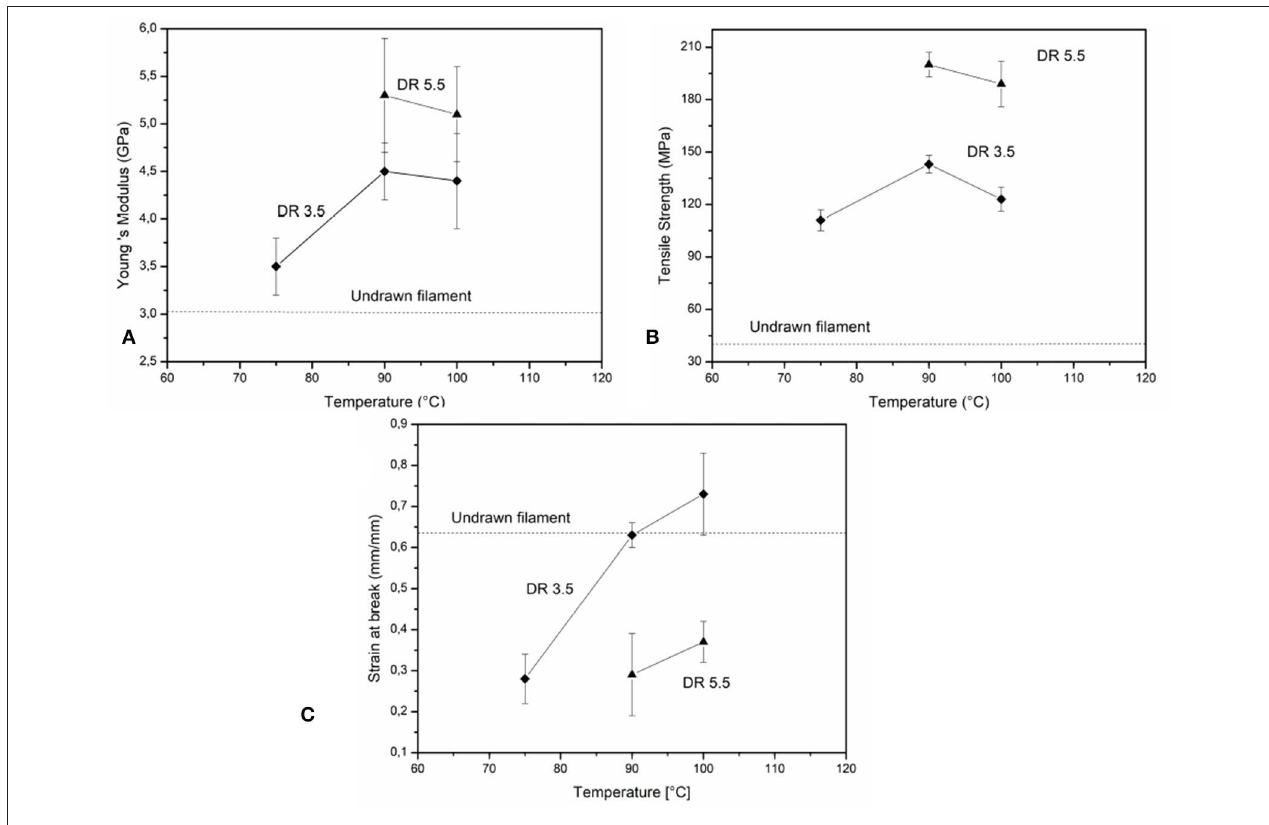
FIGURE 12 | Tensile parameters values as a function of the drawing temperature for the Cu-filled PLA filaments drawn at two different draw ratios. (A) Young’s modulus. (B) Tensile strength. (C) Strain at